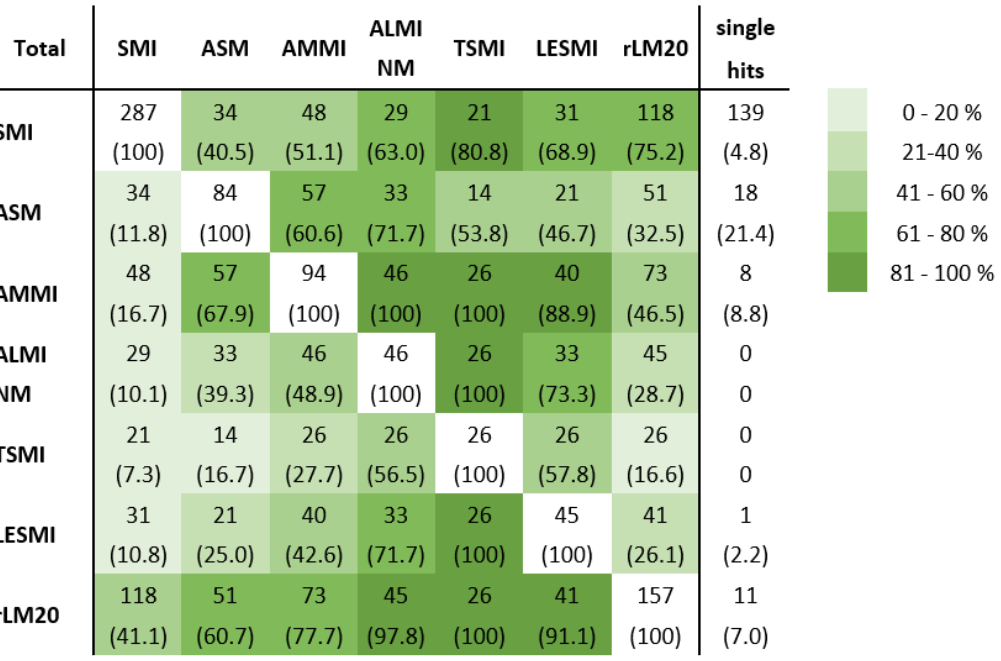
Figure 2. Comparability of sarcopenia diagnosis by use of different DXA-derived indices. SMI, LESMI, rLM20, AMMI, TSMI, ALMI NM and ASM were used in this figure since rLM20 included rLMABC identified sarcopenic persons and ALMI Min in ALMI NM. Each square shows the total numbers of individuals recognised as sarcopenic by the two compared indices (percentage in brackets). The shade of grey indicates the range of overlap as a percentage between the diagnoses of sarcopenia by the two compared indices. The shades range from 0 to 20% accordance (light grey) in steps of 20 percent each up to 81 to 100% accordance (dark grey). DXA: dual-energy X-ray absorptiometry; SMI: skeletal muscle mass index; ASM: appendicular skeletal muscle mass; AMMI: appendicular skeletal muscle mass index; ALMI: appendicular lean mass index; NM: reference values New Mexico; TSMI: total skeletal mass index; LESMI: lower extremity skeletal muscle mass index; rLM20: relative lean mass (20th percentile).